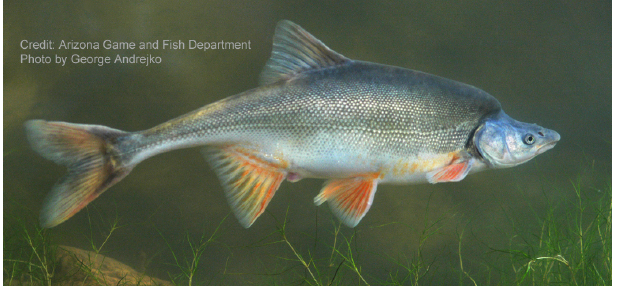
Fig. 4 . Adult humpback chub ( Gila cypha